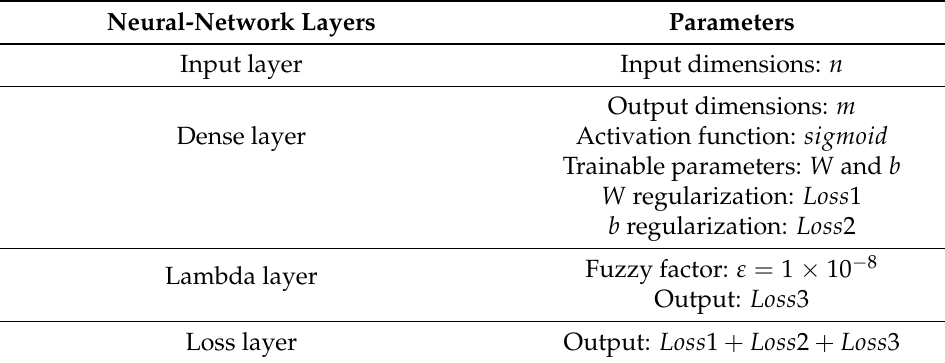
Table 1. Parameter settings of the neural-network